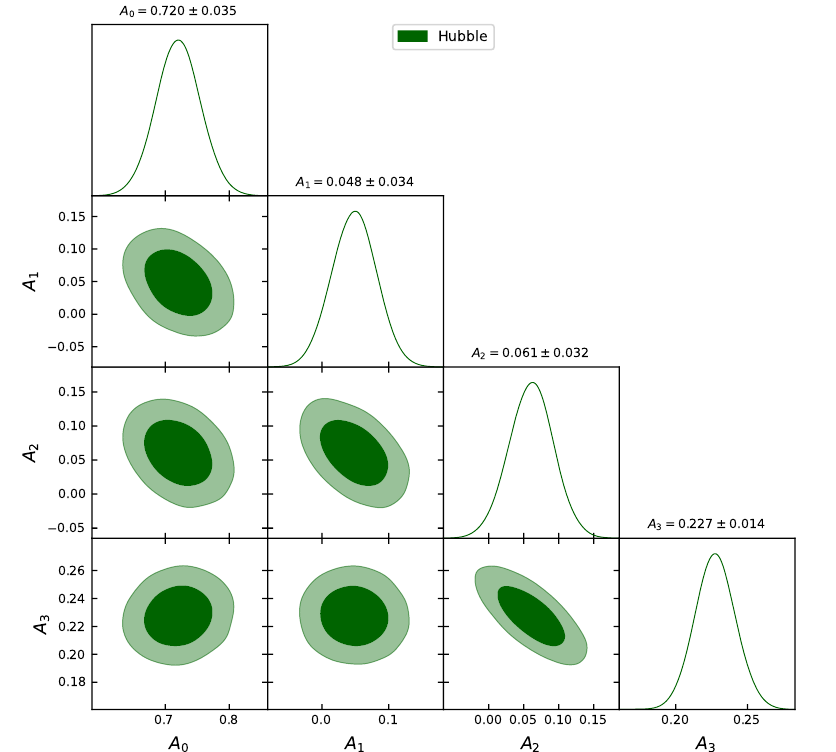
Figure 3. The marginalized constraints on the coefficients in the expression of Hubble parameter H ( z ) in Equation (26) are shown by using the Hubble sample.